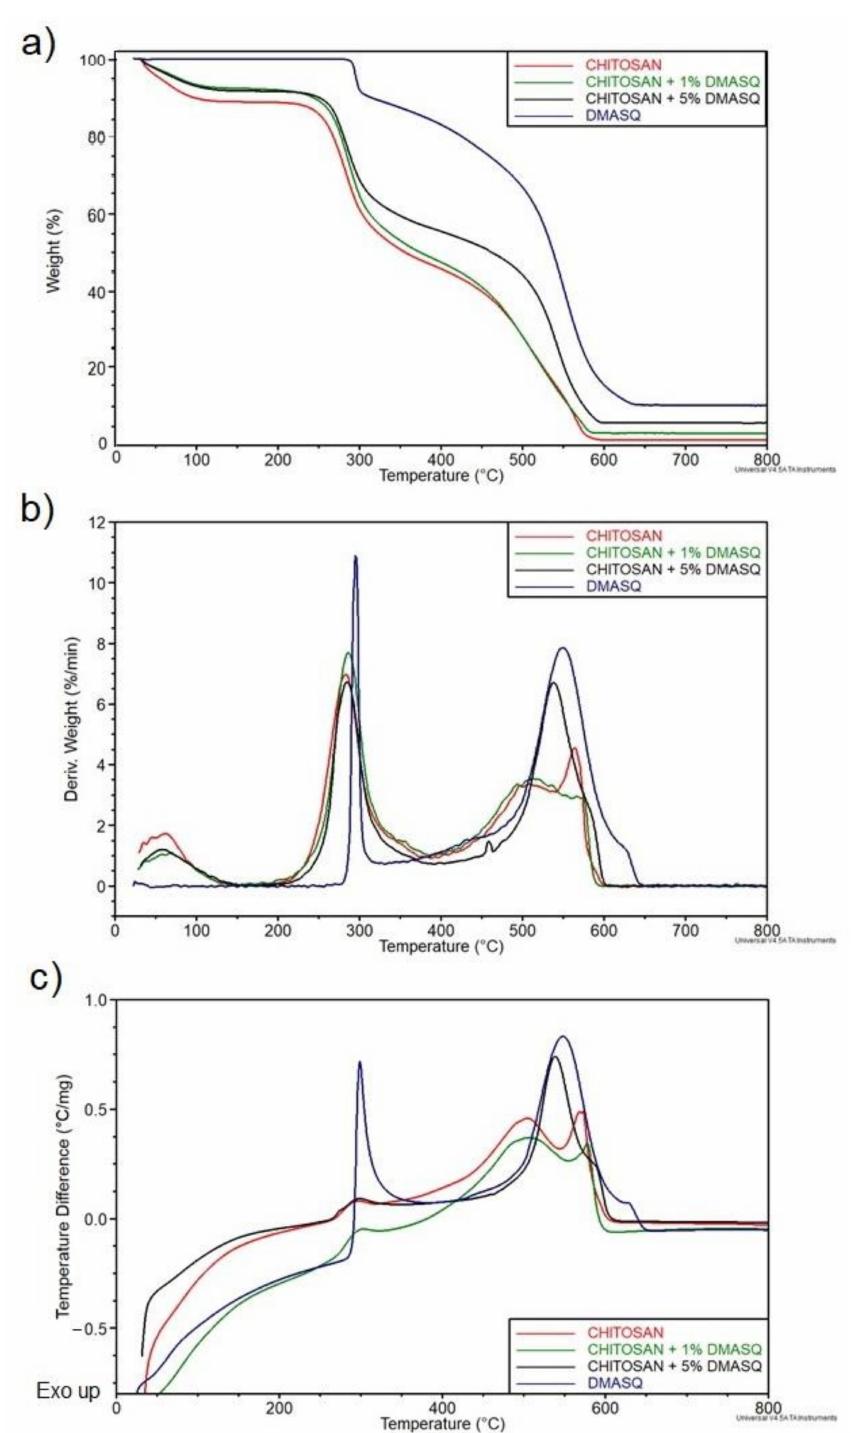
Figure 11. TG ( a ), DTG ( b ), and DTA ( c ) curves of chitosan, DMASQ, and chitosan with the addition of 1 and 5%